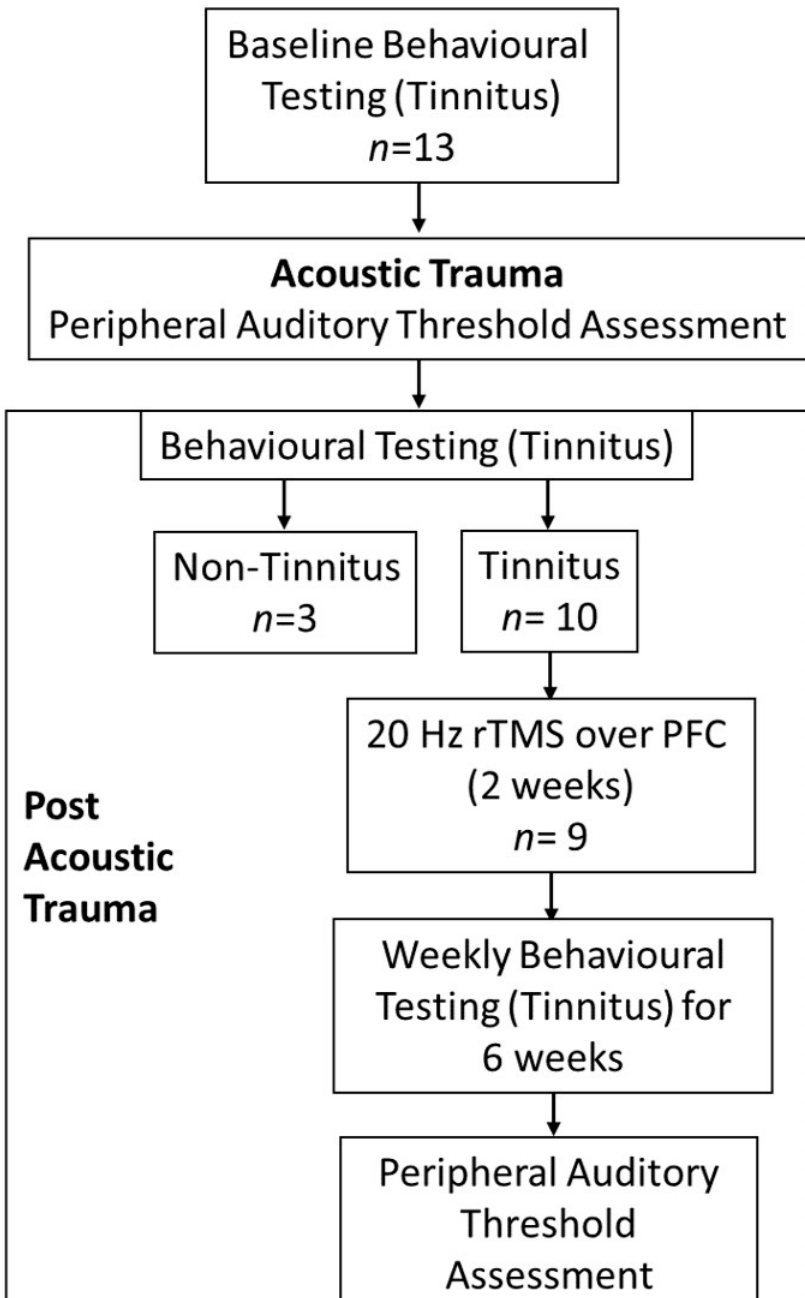
Figure 1. Experimental flow diagram. First, baseline measures for behavioral outcomes (tinnitus testing) were obtained. Then, surgery, under full anesthesia, was performed to assess peripheral auditory thresholds followed by a unilateral acoustic trauma (AT) to induce hearing loss. Following recovery, behavioral tests for tinnitus were performed at weekly intervals. Development of tinnitus was followed by high-frequency and high-intensity rTMS treatment over the prefrontal cortex, administered for ten min a day, on weekdays only, over a two-week period. After two weeks of treatment, animals were reassessed for behavioral signs of tinnitus, every week for six weeks. Animals were then euthanized and brains harvested for immunohistochemical analysis.